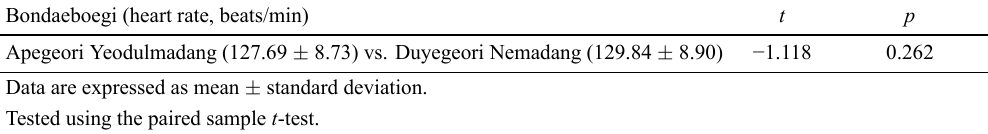
Table 6. Differences among Majumegigi’s Majugeori, Maguemjil, Allermegigi, Ikhimsu, and Majuchagi. Majumegigi (heart rate, beats/min)